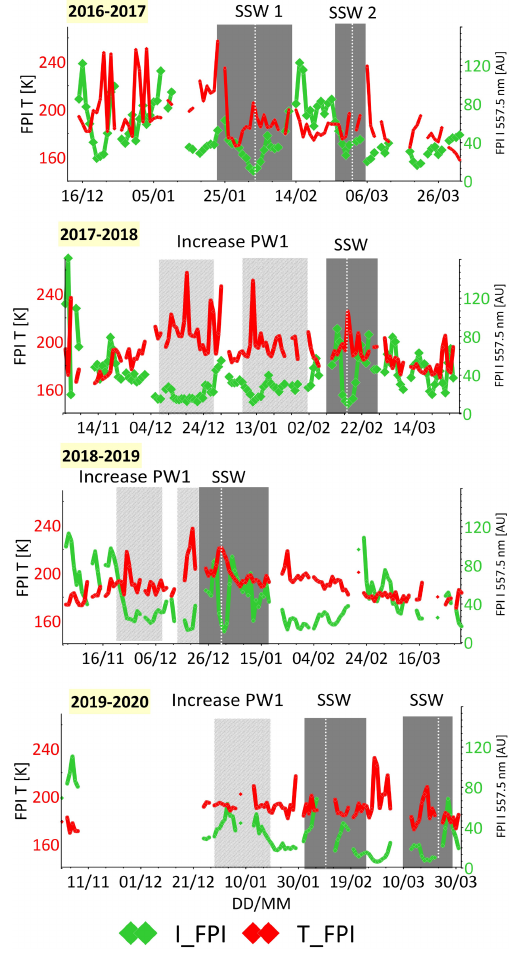
Figure 14. FPI-measured 557.7nm emission (green line), tempera- ture (red line), the PW1 amplitude increase period (light grey rect- angle), the SSW periods (grey rectangle), and the day of the SSW maximal temperature (dotted white vertical